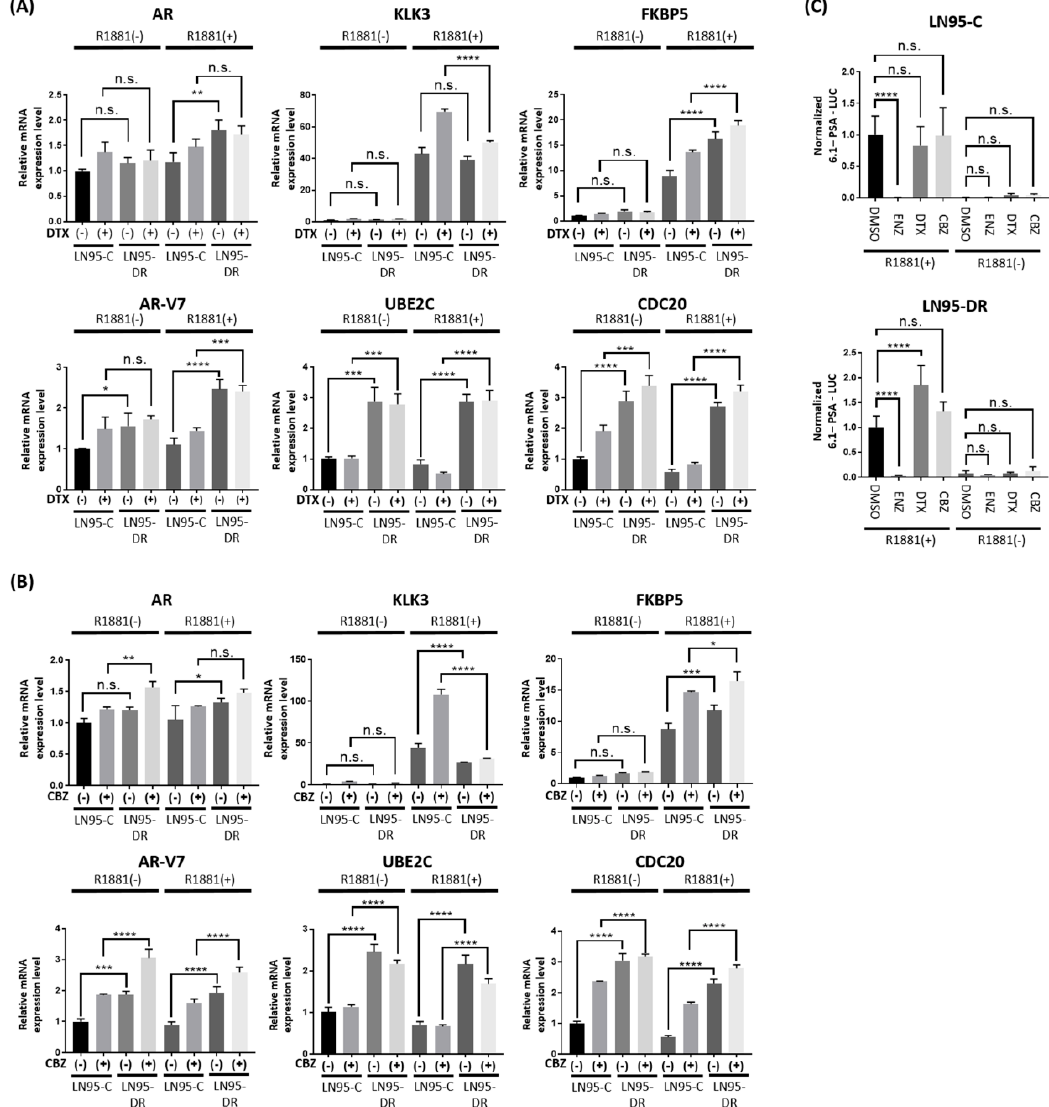
Figure 4. Increased expression of AR-V7 target genes in LNCaP95-DR. Levels of mRNA for FL-AR, AR-V7 and their target genes plus PSA (6.1 kb)-luciferase activities in LN95-C and LN95-DR in response to the synthetic androgen R1881 and taxanes. Transcript levels of FL-AR, KLK3, FKBP5, AR-V7, UBE2C, and CDC20 normalized to transcript levels of GAPDH. LN95-C and LN95-DR were treated with DMSO, docetaxel (5 nM) ( A ) or cabazitaxel (10 nM) ( B ) for 1 h prior to the addition of R1881 (1 nM) or EtOH for 48 h. For the luciferase assay ( C ), LN95-C and LN95-DR were treated with DMSO, enzalutamide (10 µ M), docetaxel (5 nM), or cabazitaxel (10 nM) for 1 h prior to treatment with R1881 (1 nM) or EtOH for 48 h. n.s.: not significant; * p < 0.05; ** p < 0.01; *** p < 0.001; **** p < 0.0001.